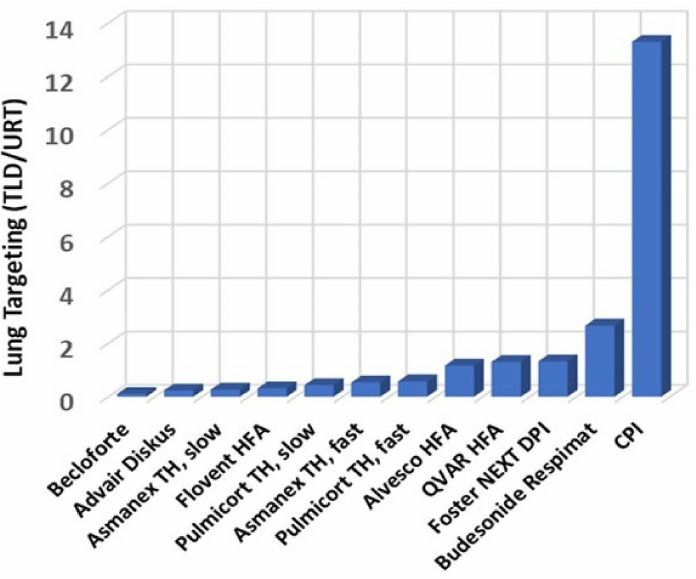
Figure 7. Lung targeting observed for CPI relative to various ICS formulations